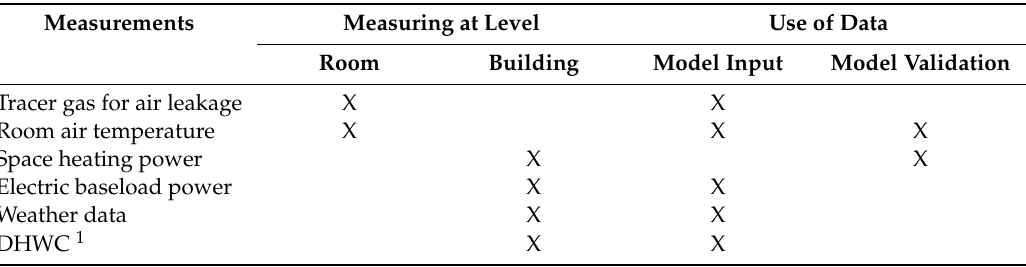
Table 2. Overview of measurements.